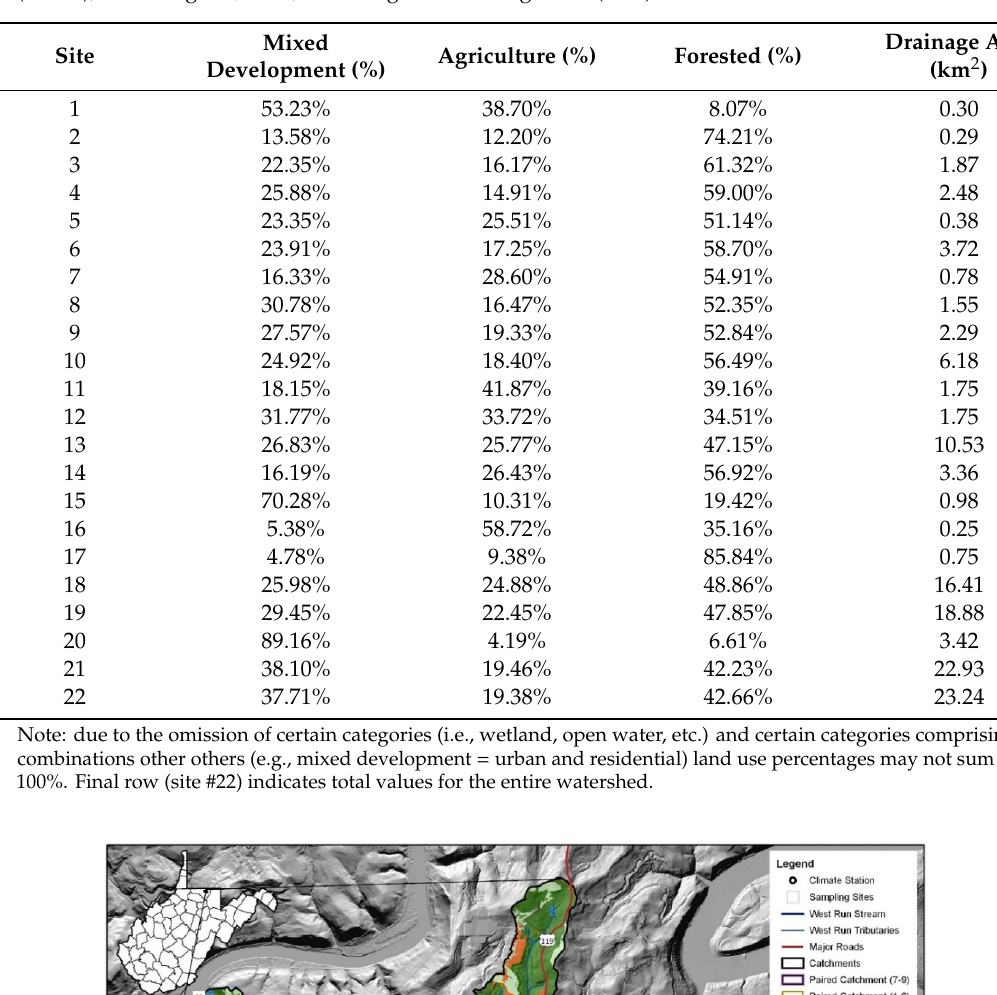
Table 1. Land use / land cover characteristics (% cover) of 22 monitoring sites in West Run Watershed (WRW), West Virginia, USA, including total drainage area (km 2 ).